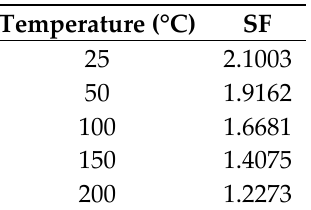
Figure 1. Permeation of simple gases CO 2 and N 2 and CO 2 /N 2 mixture. Table 1. Results of gas separation factor.